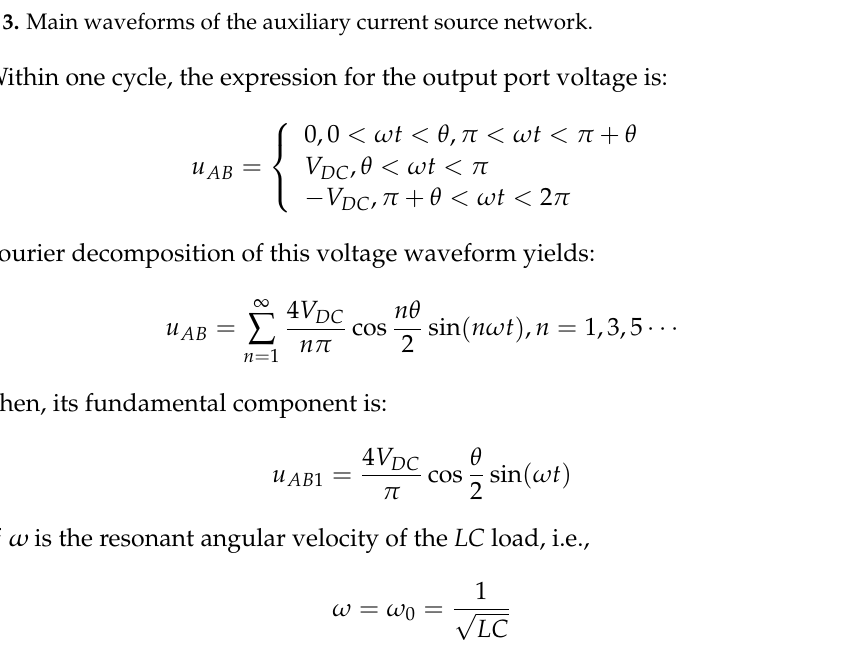
Figure 3. Main waveforms of the auxiliary current source network.